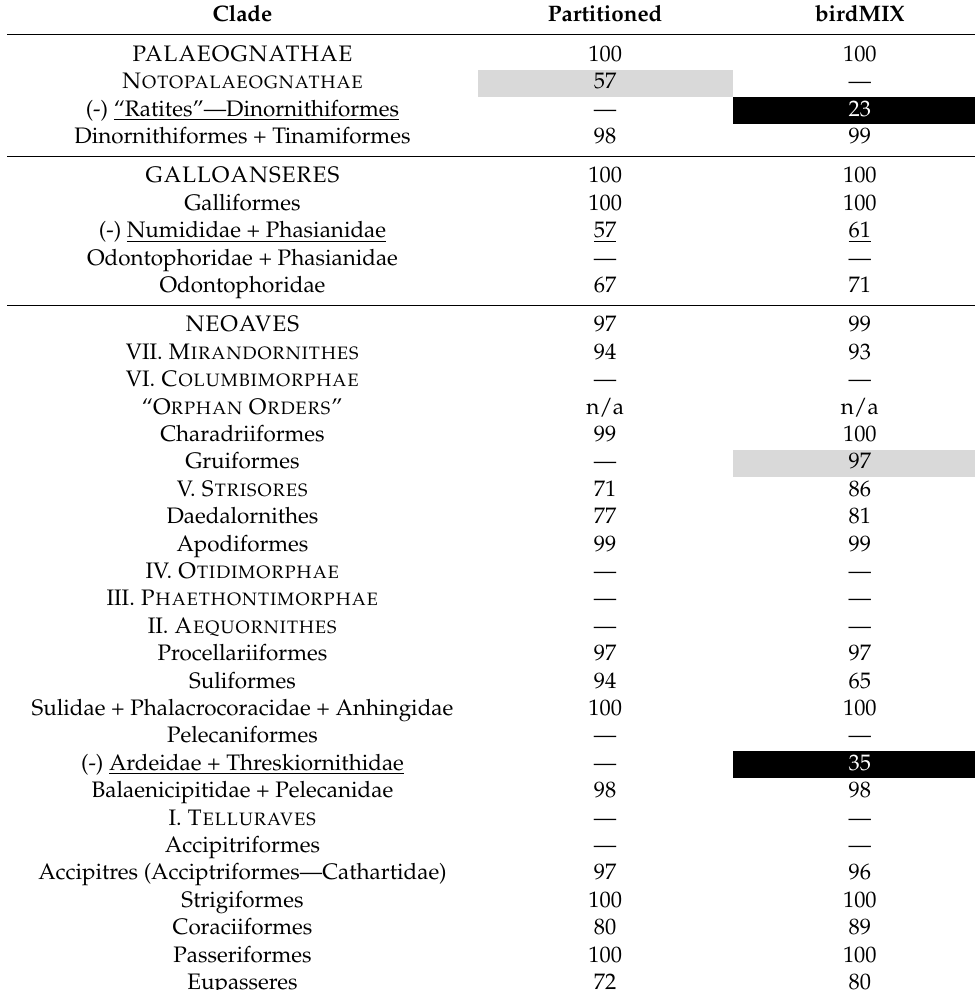
Table 3. Support for selected clades 1 in analyses of all amino acid sites using partitioned and mixture